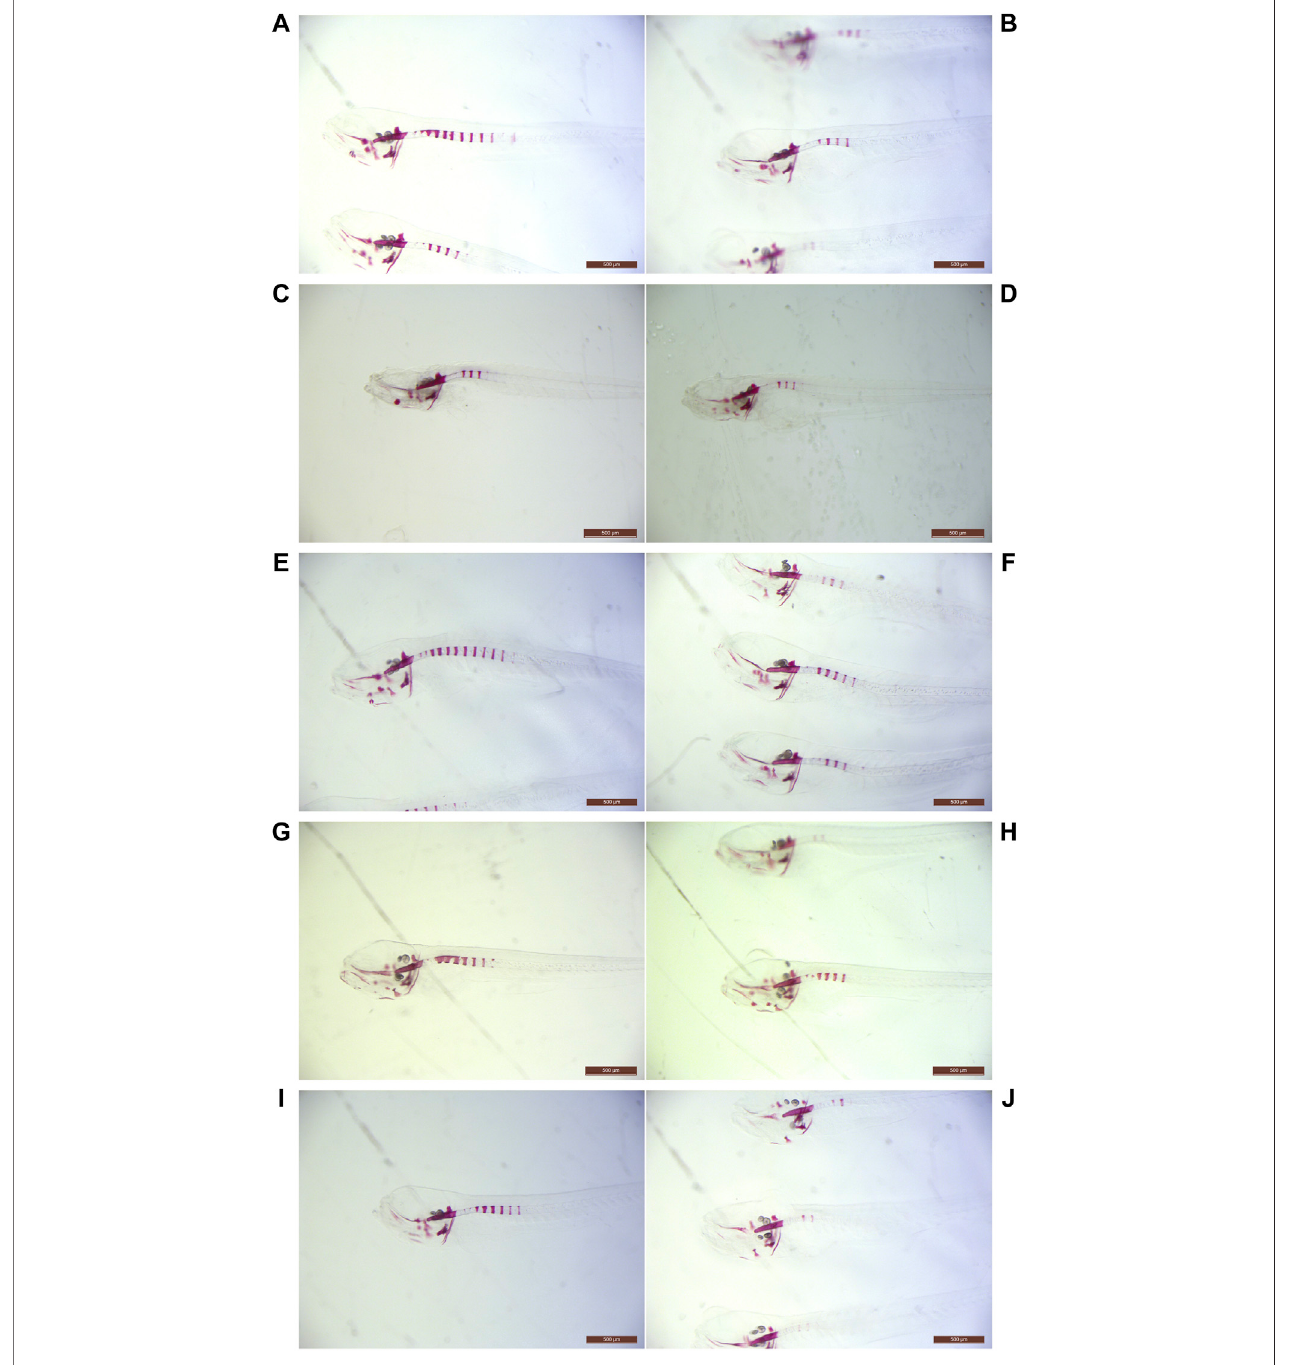
FIGURE 1 | Light microscopy examples of ARS-stained abcc6a cmg52/cmg52 specimens. Examples of 10 dpf untreated (A , C , E , G , I) and treated (B , D , F , H , J) abcc6a cmg52/cmg52 animals. Compounds per set are (A , B) 80 µM vitamin K1, (C , D) 20 µM sodium thiosulfate (E , F) 100 µM etidronate, (G , H) 100 µM alendronate and (I , J) 10 mM magnesium